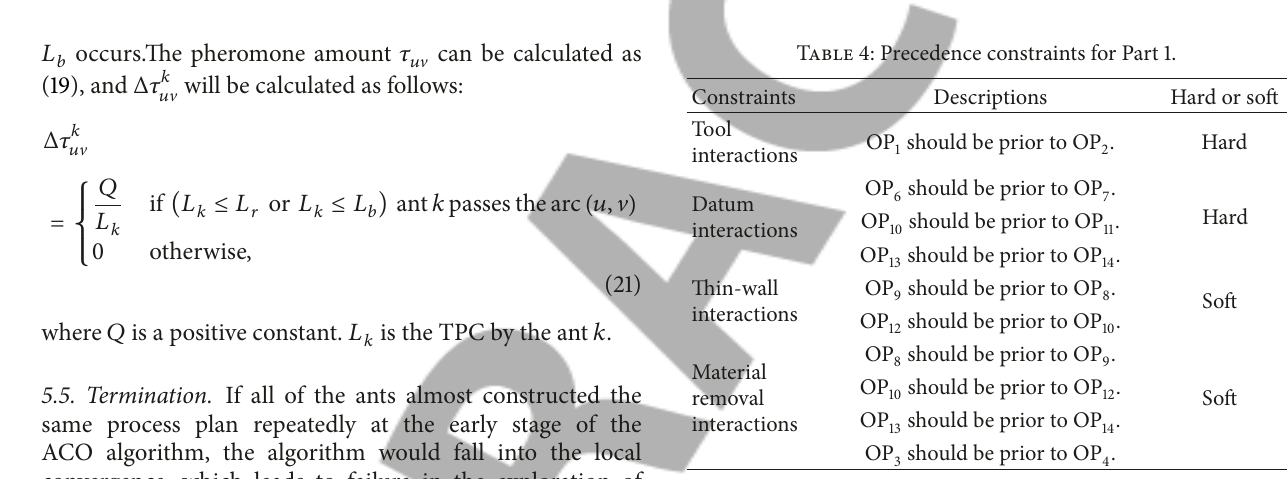
Table 4: Precedence constraints for Part